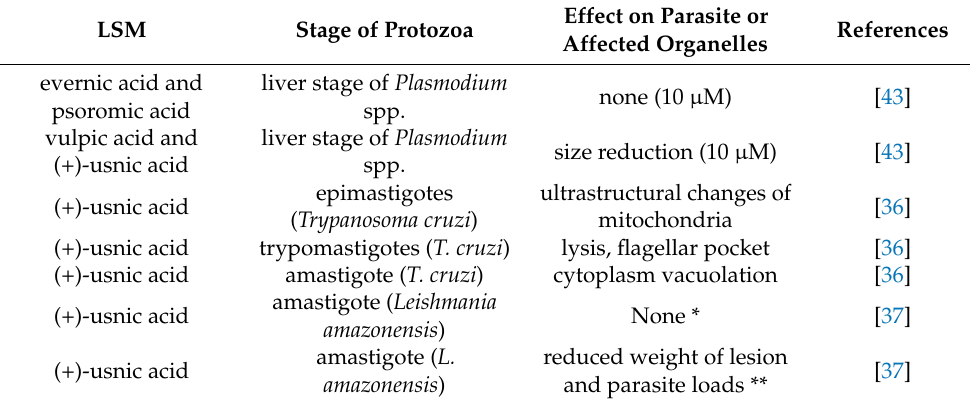
Table 5. Physiological and morphological effects of LSMs on parasitic